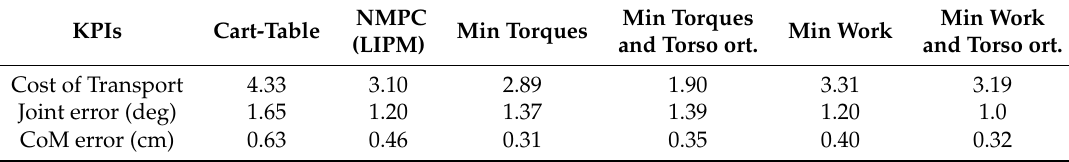
Table 5. [Hardware experiment result.] Key Performance Indicators (KPIs) for the periodic step. Note that in the case of motions obtained with the cart-table and NMPC, no explicit periodicity constraints were introduced, so the data are approximated on an intermediate step that would correspond to a periodic step.